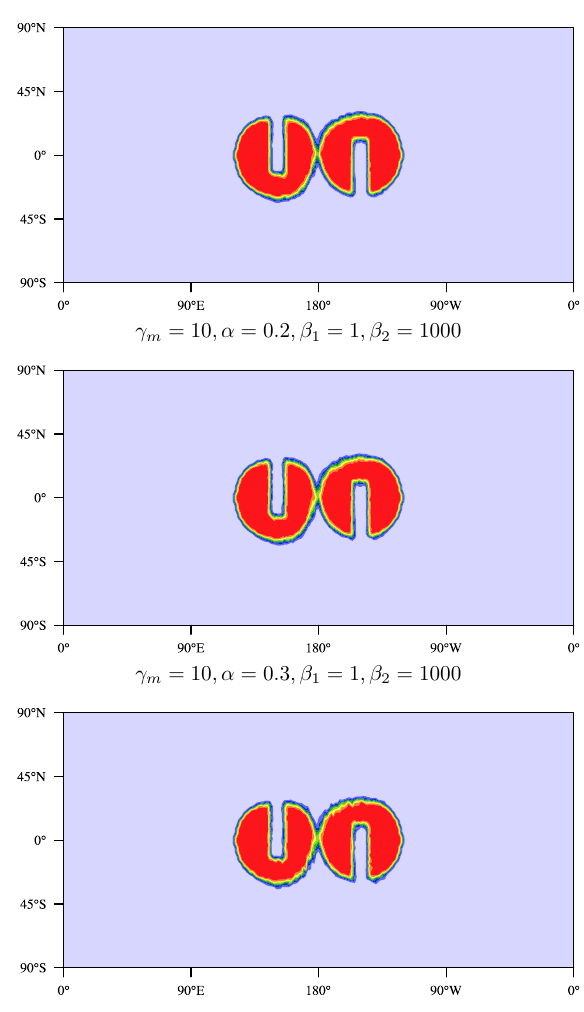
Figure 13. The effects of interparcel mixing with the slotted cylin- ders initial condition. There are three parameter configurations as shown on the top of the each row. The tested parameter that controls the amount of tracer mass distributed to the surrounding parcels is α